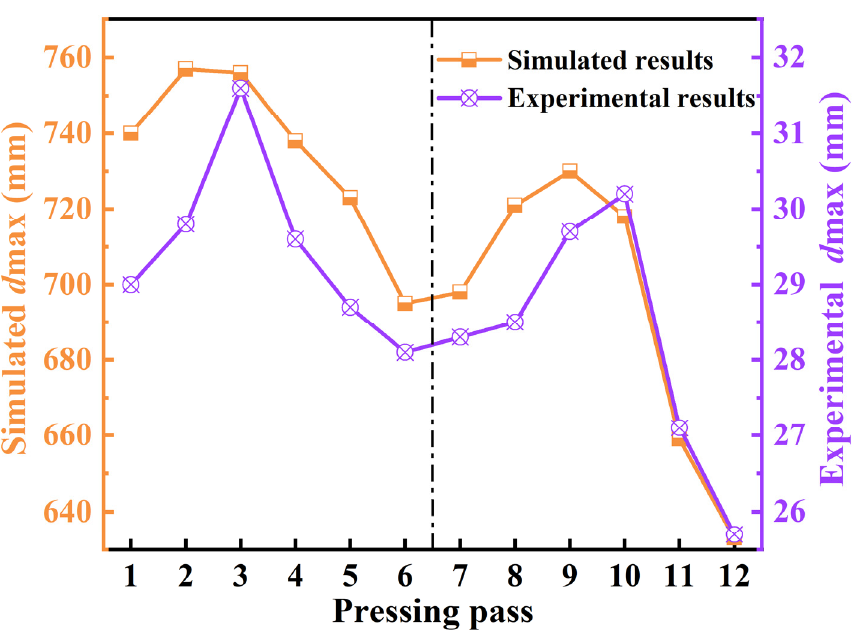
Figure 13. Inner hole distortion of M3 scheme (the experiments with shrinkage ratio of 25:1).